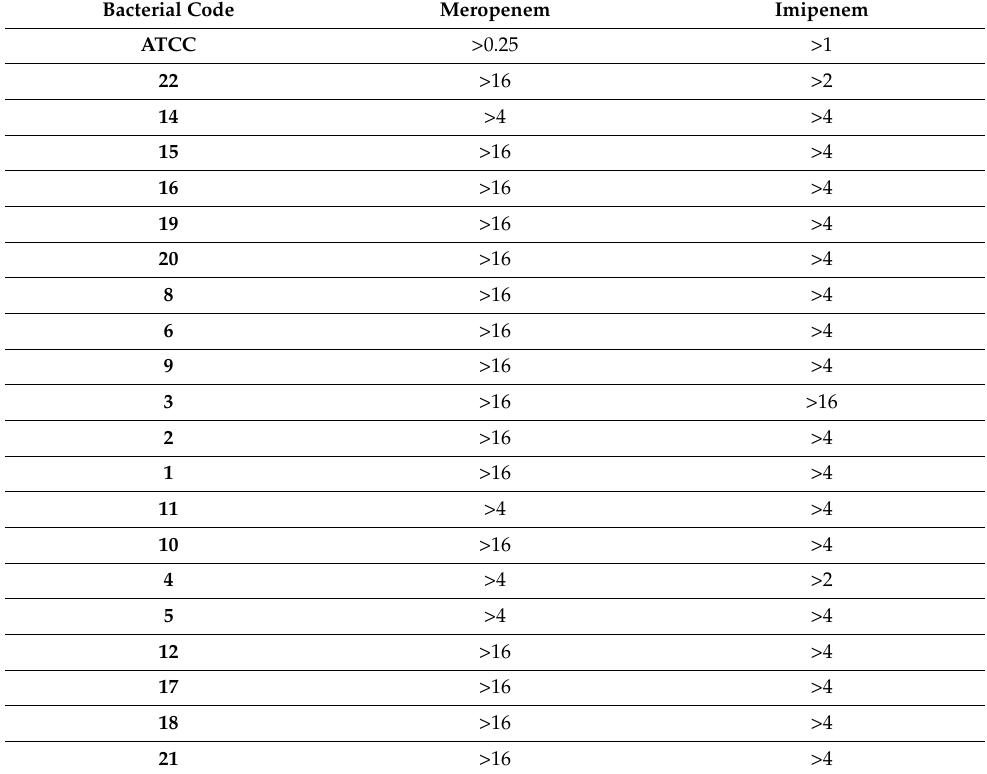
Table 3. MIC of imipenem and meropenem antibiotics against Klebsiella pneumoniae (ATCC 700603) and tested